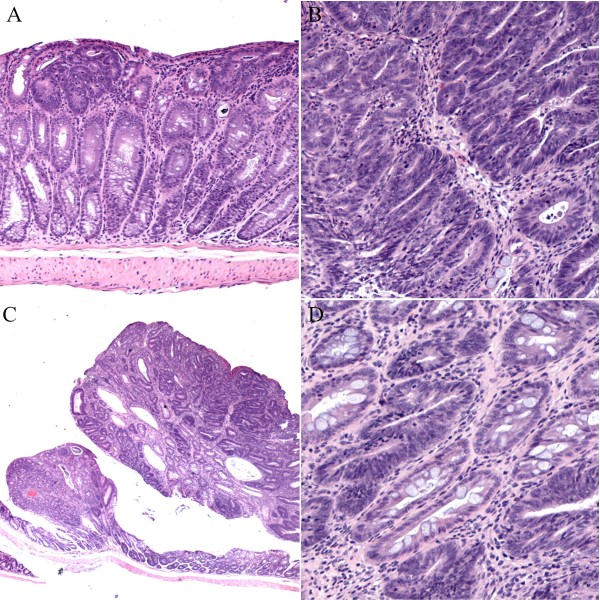
Spectrum of histologic changes in KO mice treated by azoxymethane. Early dysplastic changes were noted in many areas, some of which corresponded to ACF (A). More extensive moderate dysplasia was noted in areas of thickened mucosa (B) and in tumors/adenomas (C). Focal severe dysplasia/carcinoma in situ changes were also note (D).